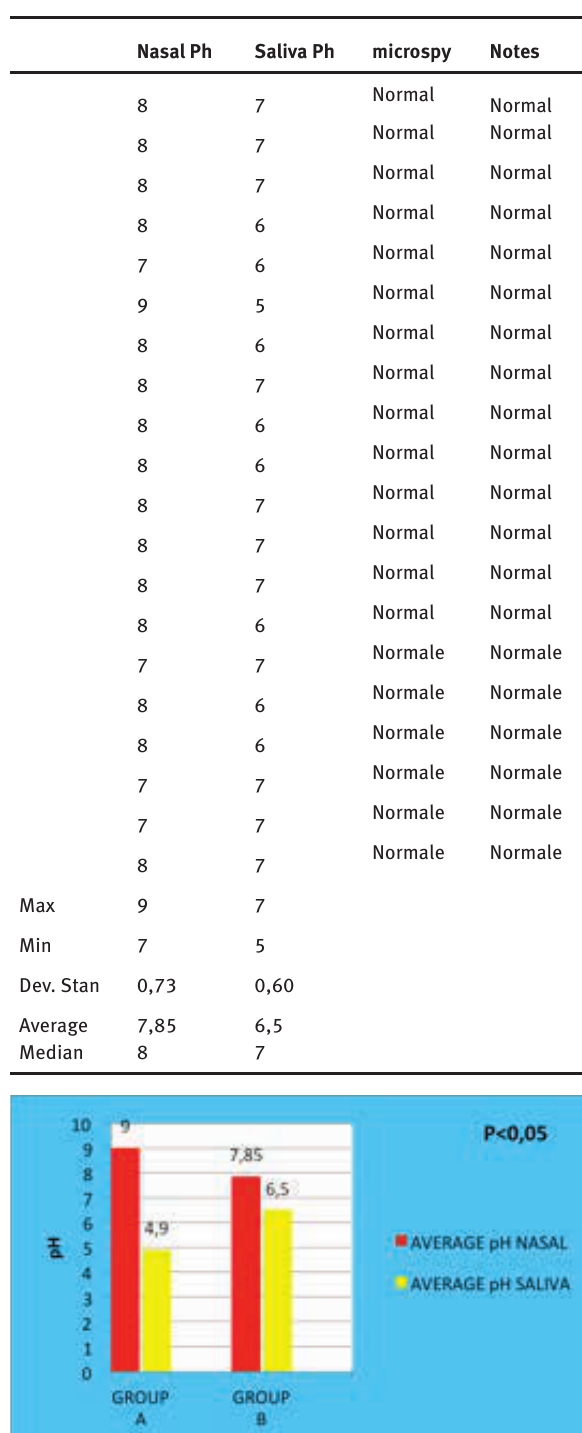
Table 3: GROUP B control